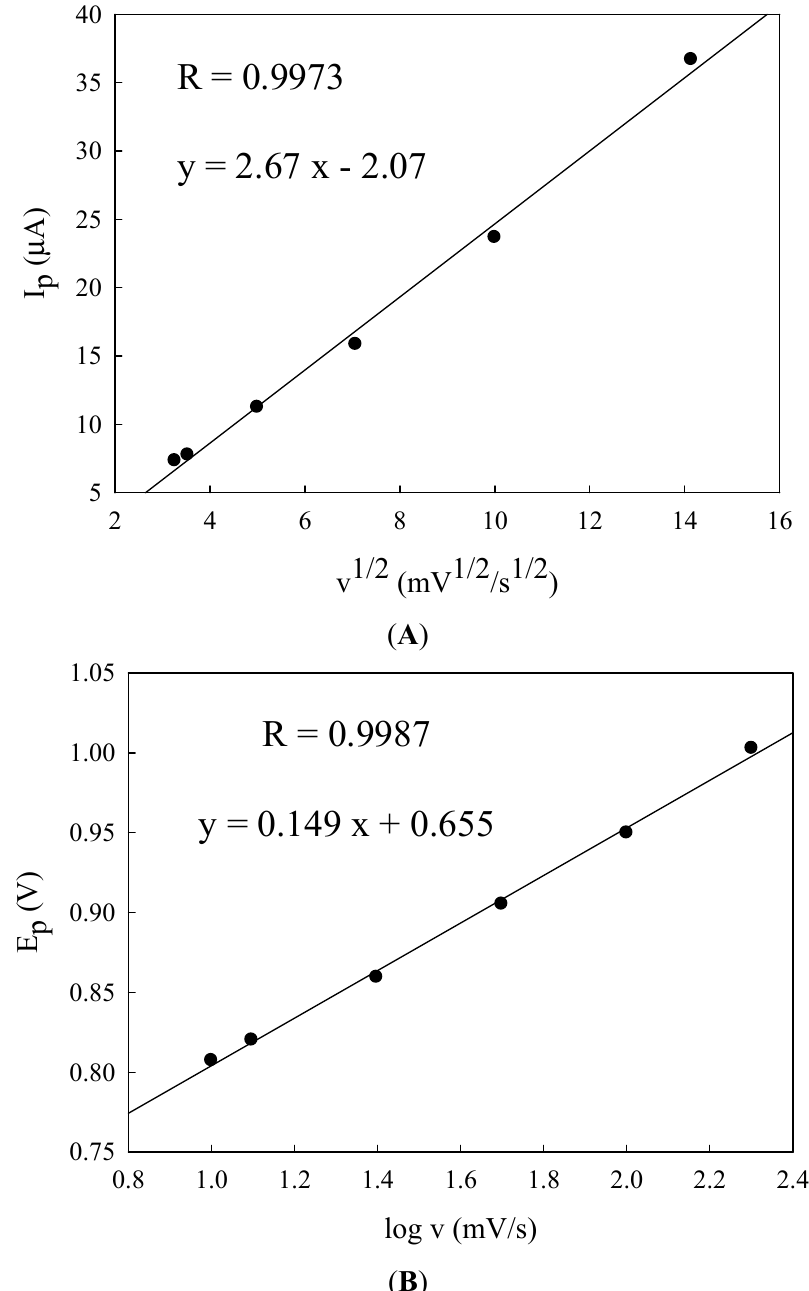
Figure 7. ( A ) Magnitude of the peak current, I square root of scan rate and ( B ) peak potentials E logarithm of scan rates from Figure